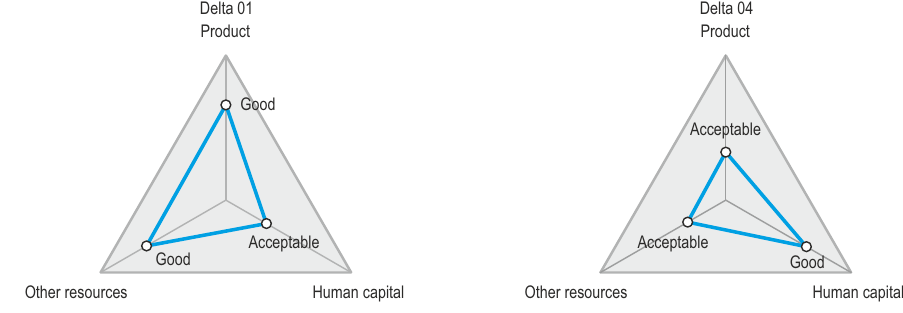
Figure 13. Examples of radar